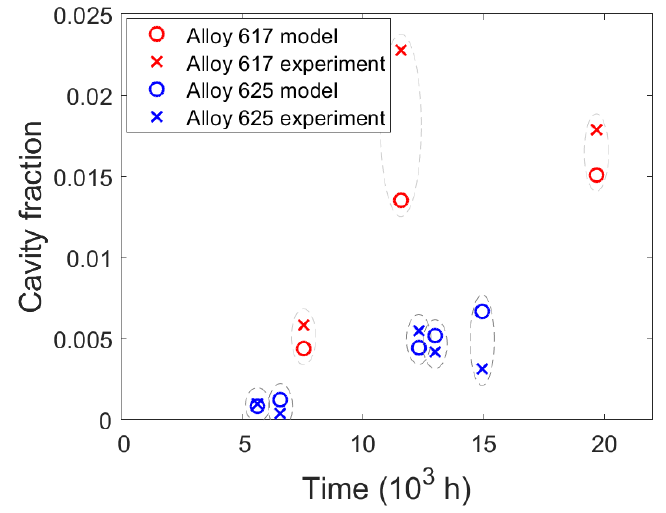
) and experiments ( X (cid:35)